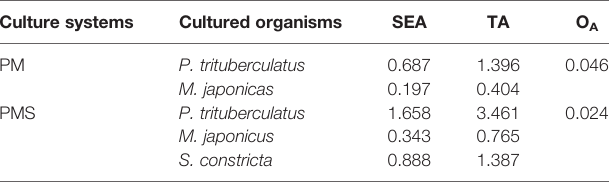
TABLE 2 | SEA, TA and Overlap of isotopic niches of cultured organisms. Culture